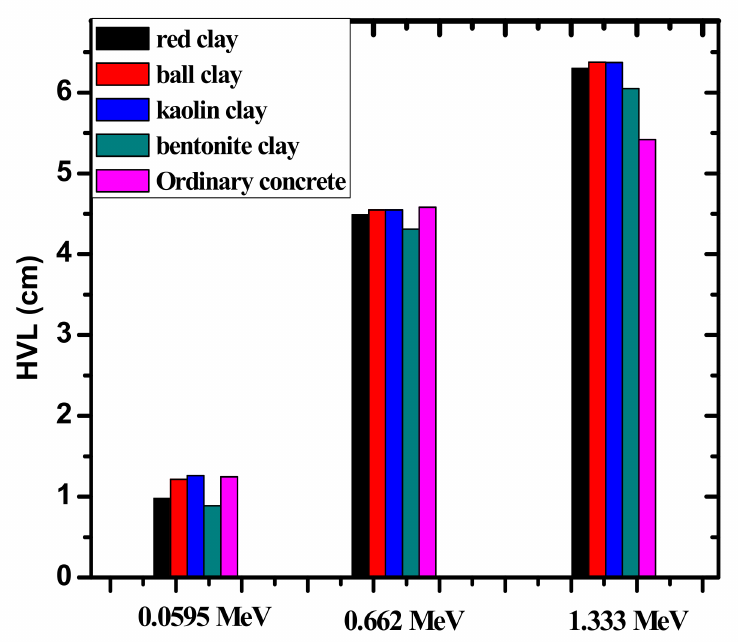
Figure 7. The experimental HVL values for the four investigated clay compared with ordinary concrete samples at three selected